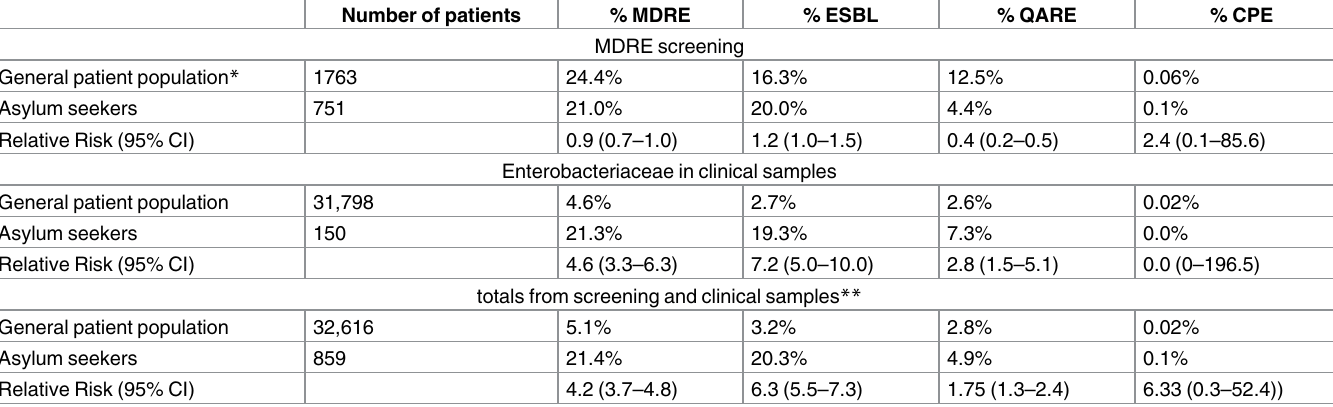
Table 3. Number of patients tested and proportions of multidrug-resistant Enterobacteriaceae(MDRE) in screening and clinical cultures, during 2014–2015,at the Certe